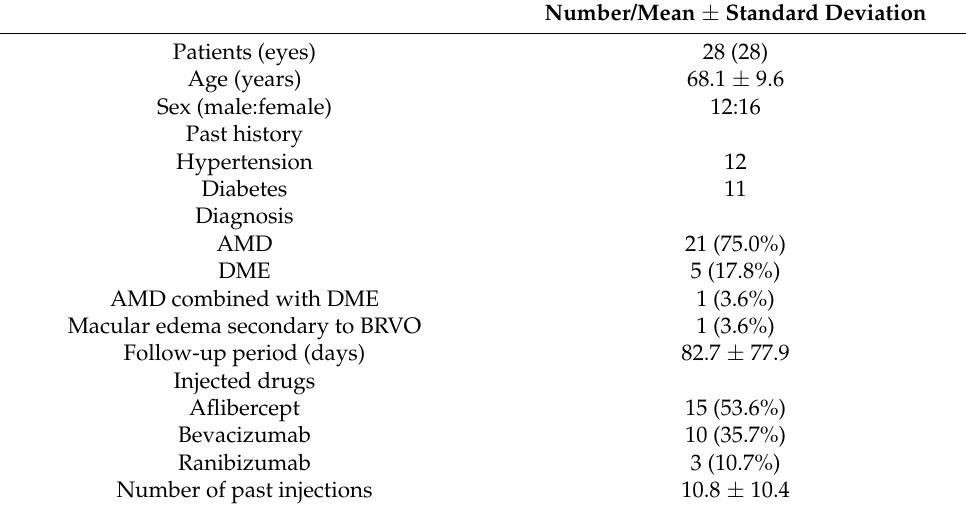
Table 1. Demographics of